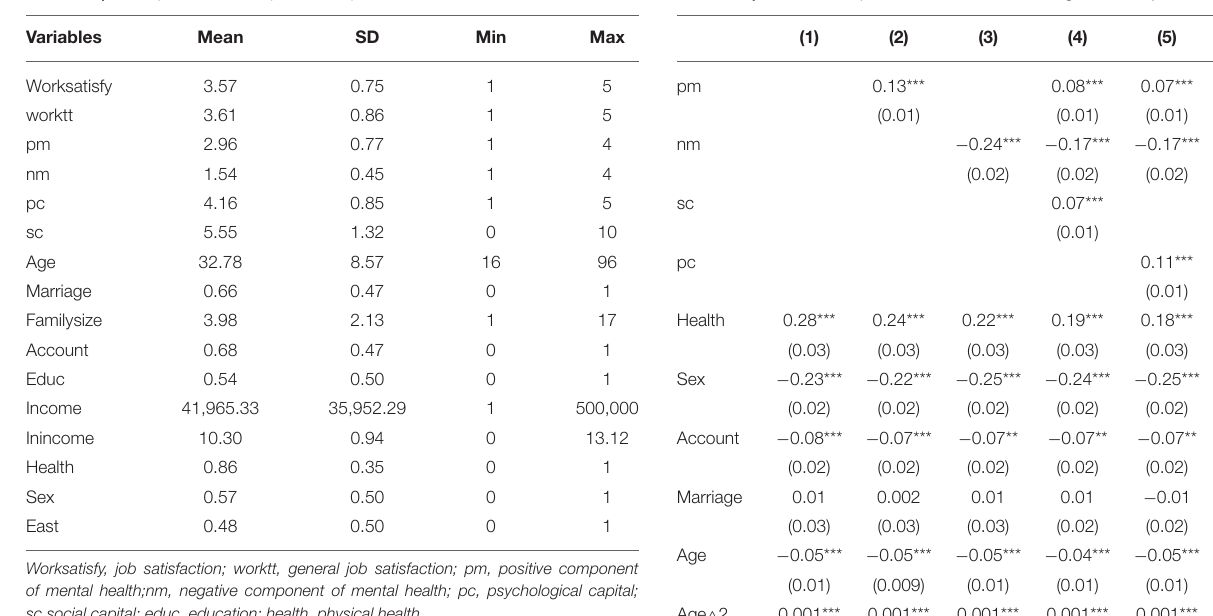
TABLE 2 | Descriptive statistics ( N = 6,741). TABLE 3 | The two components of mental health regressed on job